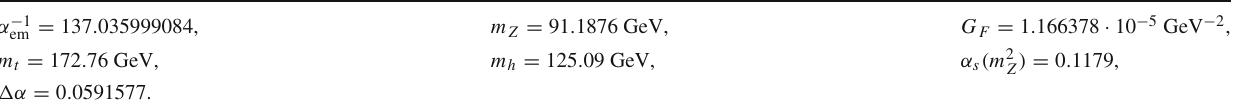
( m 2 ) = 0 . 02766 and the leptonic Z had